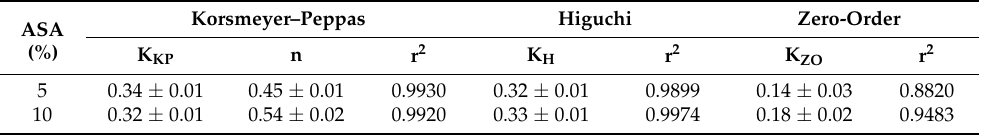
Table 1. Results of fitting the release of ASA from 3D-printed tubular grafts to Korsmeyer–Peppas, Higuchi and Zero-Order models.